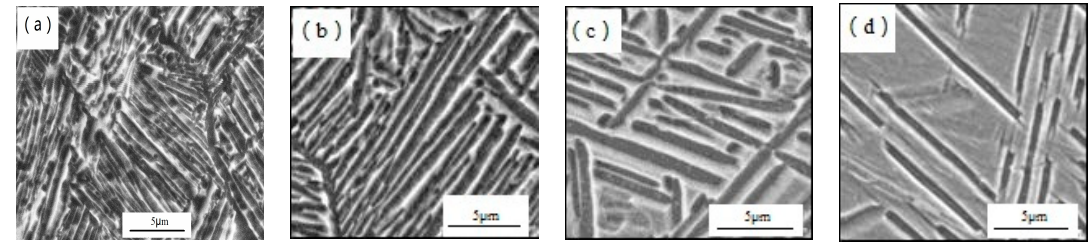
Figure 4. Secondary electron images of the lamellar α from initially microstructure II after heated up to ( a ) 700 °C; ( b ) 900 °C; ( c ) 940 °C; ( d ) 970 °C.